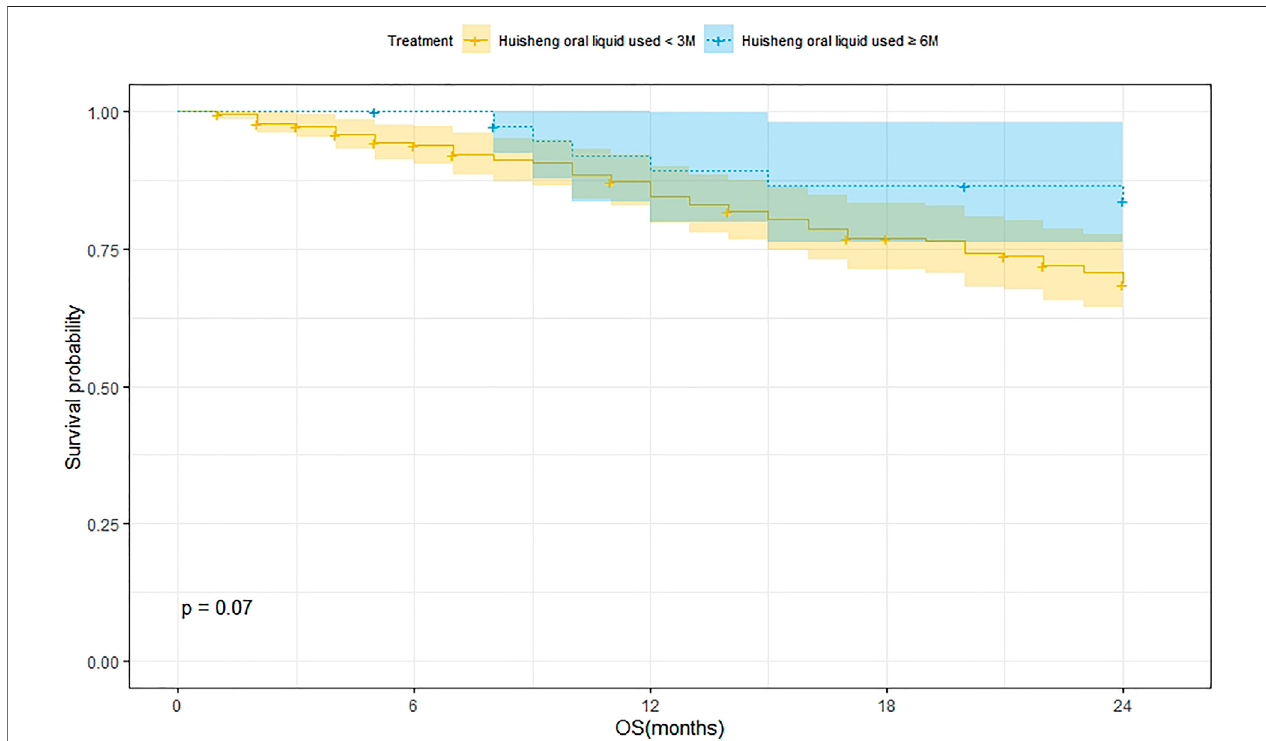
FIGURE 5 | Survival analysis of patients treated with HSOL for < 3 months and HSOL for ≥ 6 months.